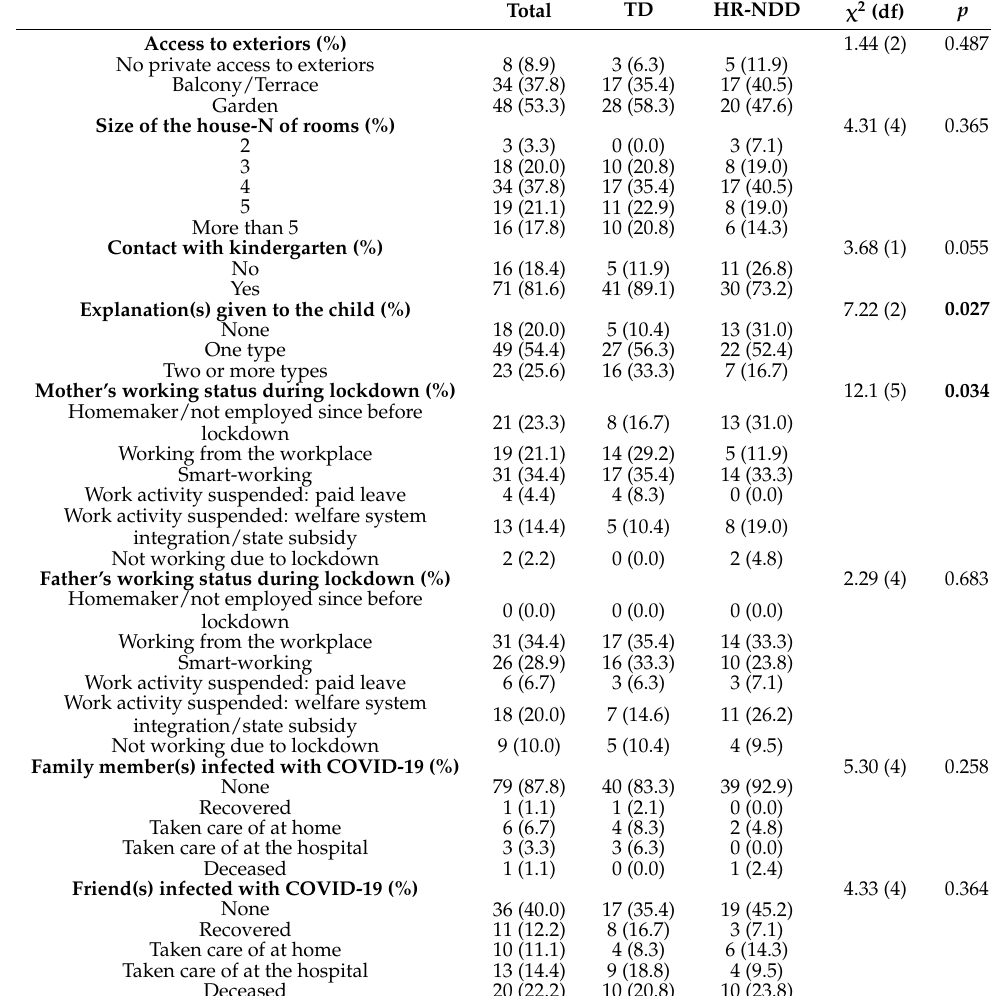
Table 2. Sample characteristics and group differences related to the ad-hoc environmental question-